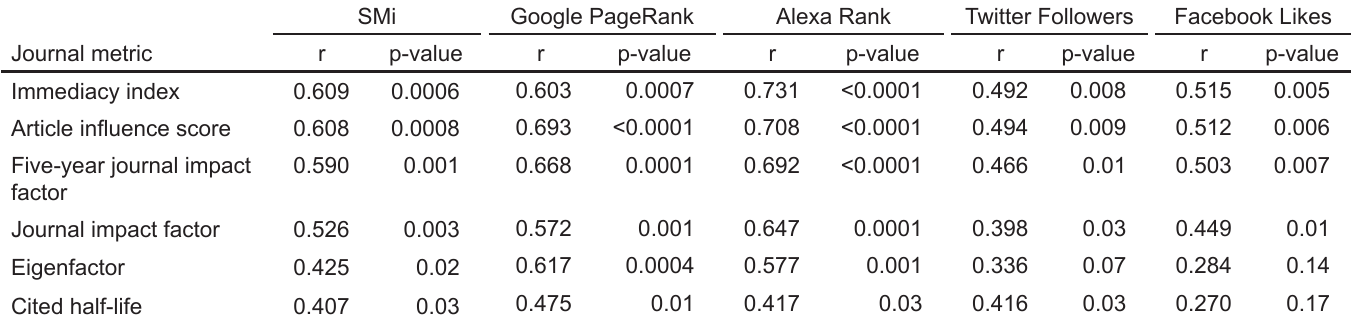
Table 4. Spearman’s correlation of the journal Social Media index (January 20, 2014) and its components with traditional journal impact metrics 22 (n=29